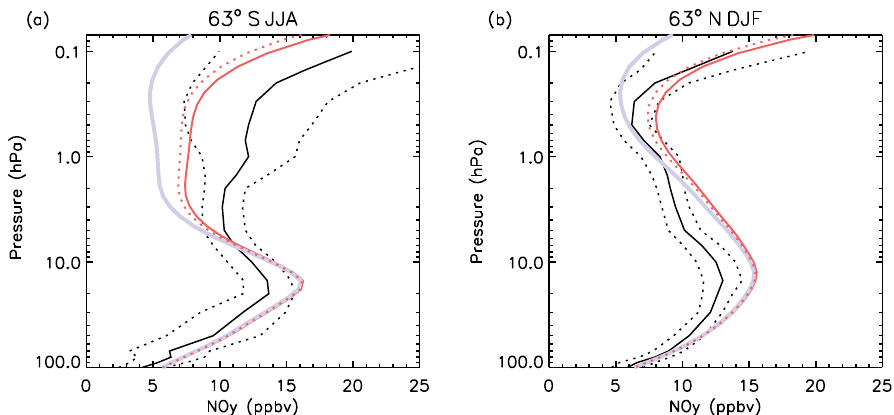
Figure 13. Comparison of 2004–2009 wintertime polar NO y climatology between ACE-FTS observations and SD-WACCM simulations. Solid black line is ACE, black dots are the average standard deviation of the monthly means. The grey line is WACCM with weak transport of auroral NO y from the lower thermosphere and no mesospheric production by medium energy electrons (MEEs), the dotted red line is stronger NO x transport but no production by MEEs, and the red line is stronger NO x transport and production by